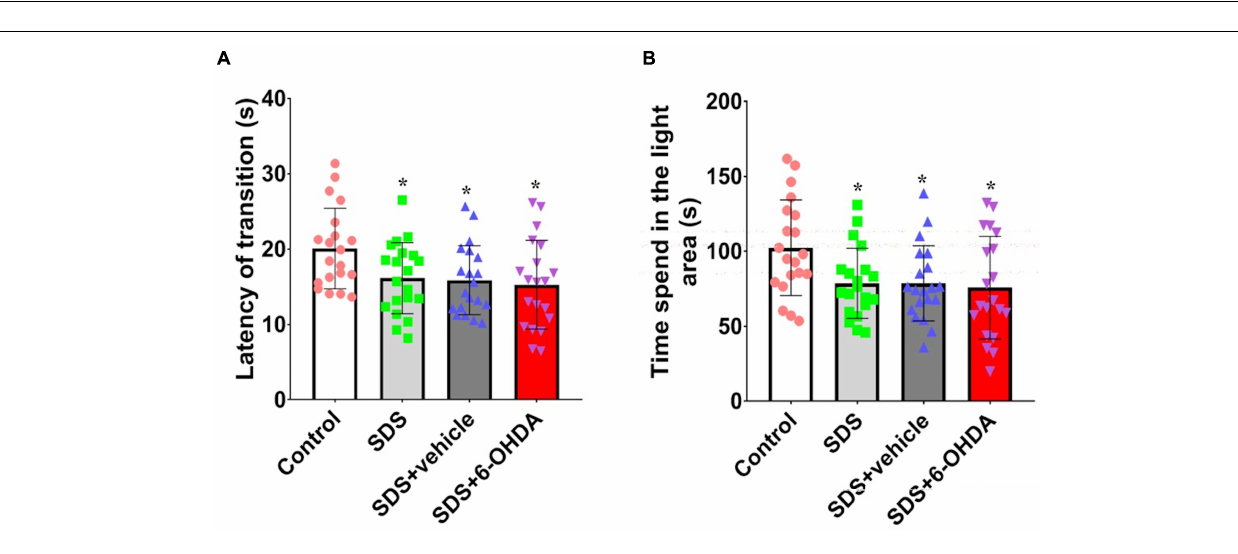
FIGURE 6 | Effects of social defeat stress on light/dark preference in the 6-OHDA lesioned mice. (A) , Escape latency period; (B) , Time spent in the light area. * p < 0.05, compared with the control group ( n = 20 per